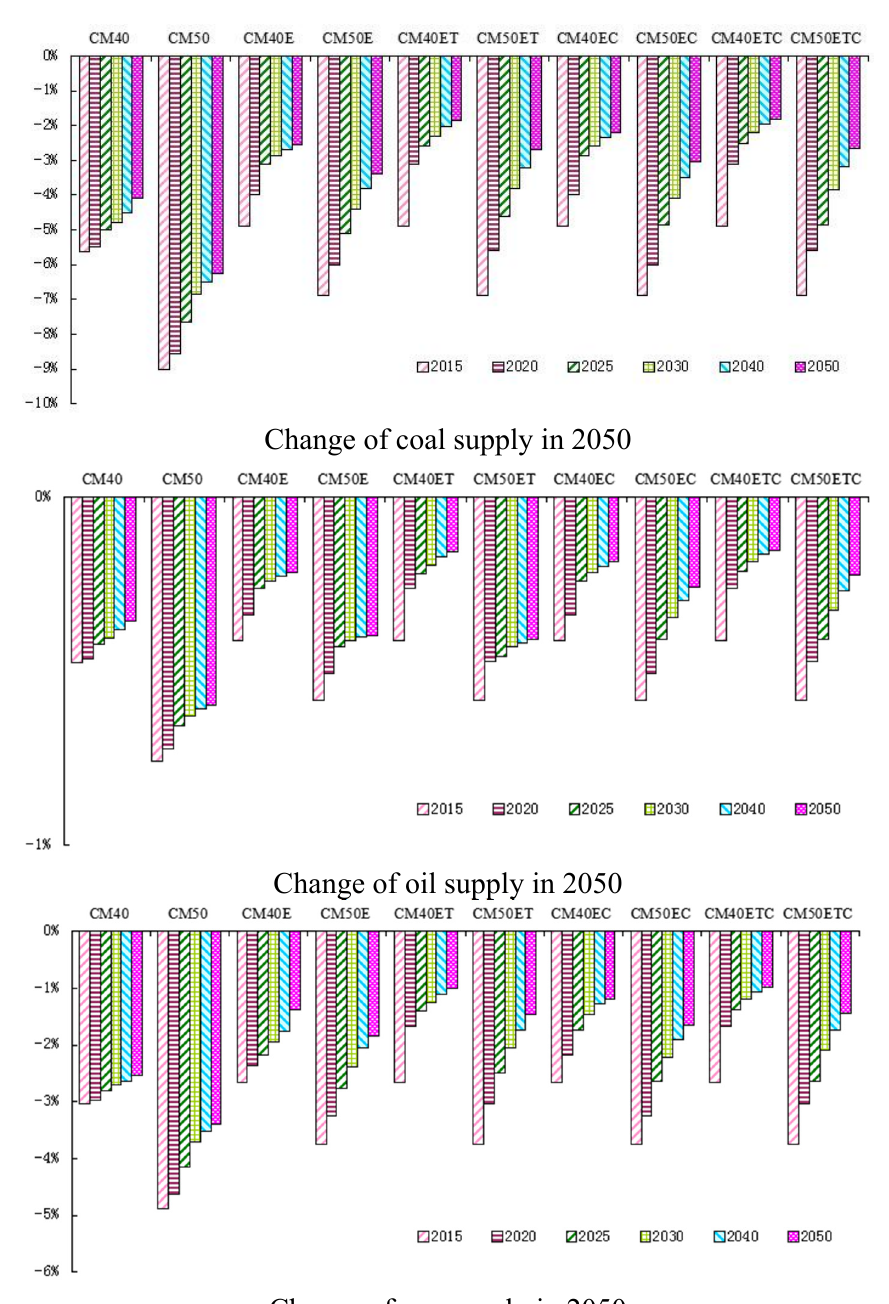
Figure 4. Change of fossil energy supply in the varied scenarios compared with BAU in 2050. Coal supply will be 3158 million tonnes coal equivalent (Mtce) in CM40ETC and 2960 Mtce in CM50ETC, accounting for 45.2% and 43.2% respectively in the total energy supply in 2050, while